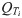
Schematics of the showing short-term and long-term prediction on the circle.(A) The circle shows quasi-attractions as internal information for agent 1. The numbers under the dots are the tags for the agents. The bold blue arc is a covering set for θ1. (B) The circle shows quasi-alignments as external information for agent 1. Each prediction point QTi determines Θi. The bold red arc is a covering set for Θ1. (C) The complete chart of our algorithm. In the first step, find an agent which has its neighbors within its repulsion range (Cov(θ˜i(t)) colored green) and apply the repulsion algorithm (the updated agent is shown in red). Repeat this until there is no agent which has its neighbors within its repulsion range. Then, construct a Delaunay triangulation from all agents’ positional information. Apply quasi-attraction (Cov(θi(t)) colored blue) and quasi-alignment (Cov(Θi(t)) colored red) and take their intersection (Ii(t) colored yellow). The agent of interest (colored blue) selects its direction from this yellow interval.